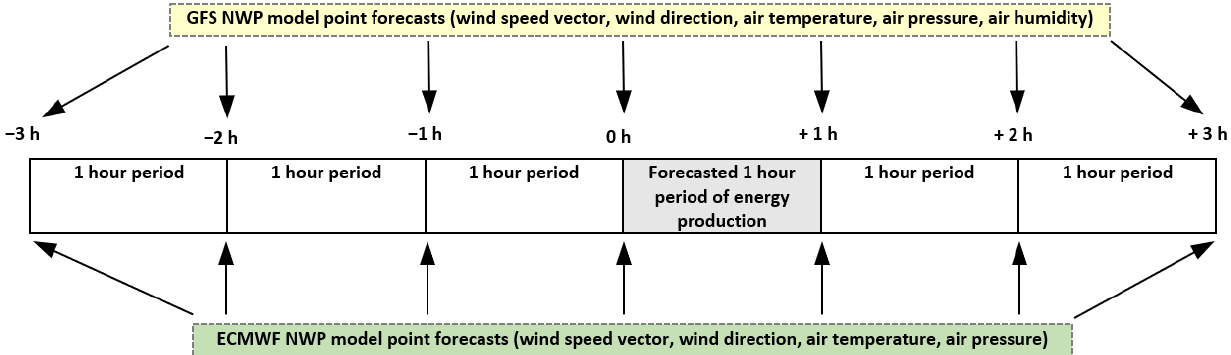
Figure 8. Relationship between time lags of GFS and ECMWF forecasts and periods of electricity generation.